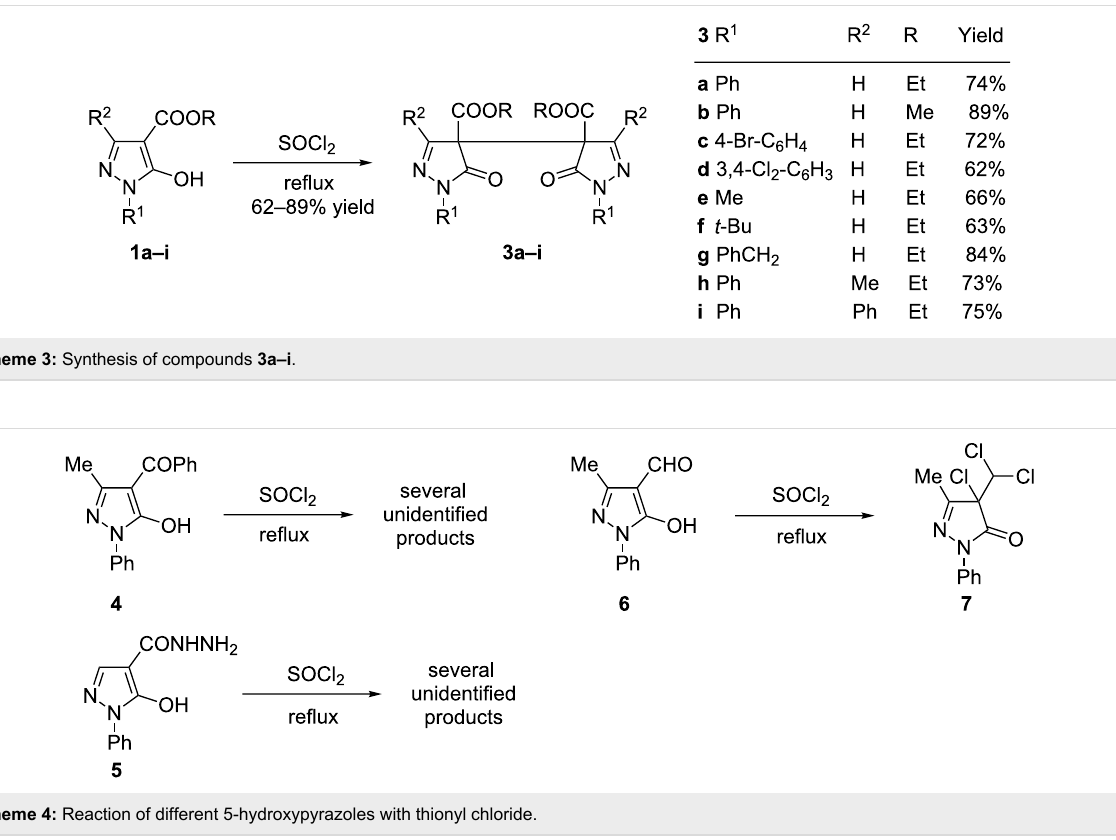
each other by weak intermolecular hydrogen bonds (C–H···O 2.523 Å, 130.64°, Figure 3).